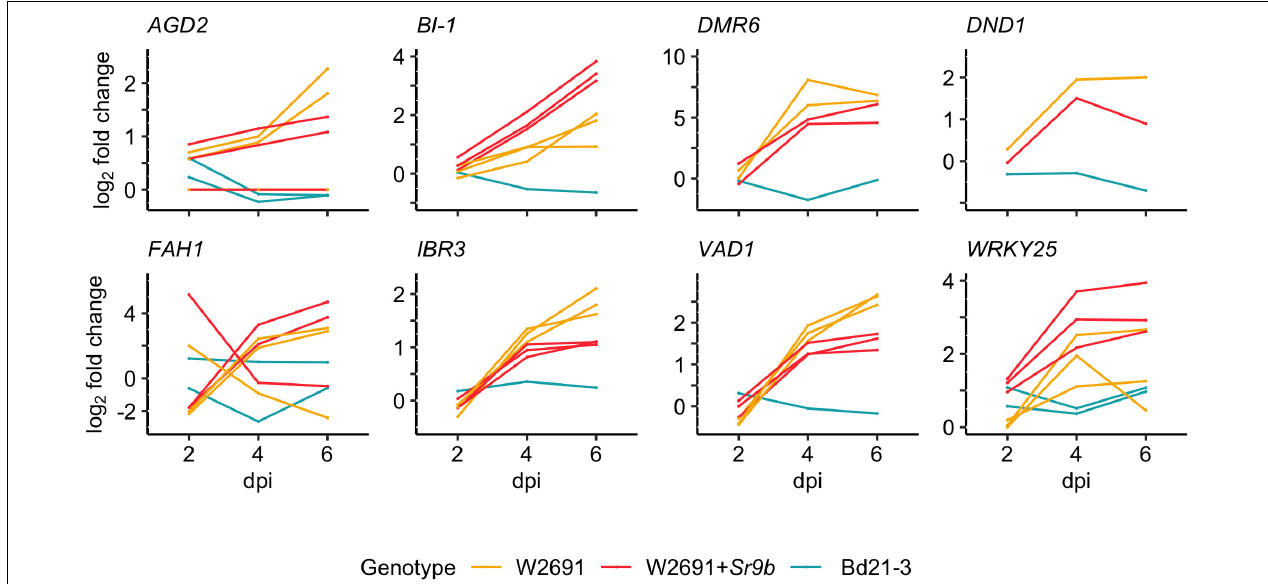
FIGURE 4 | RNAseq expression profile patterns of selected orthogroups containing candidate S genes in T. aestivum (W2691 and W2691+ Sr9b ) and B. distachyon (Bd21-3) genotypes throughout infection with P. graminis f. sp. tritici . Log 2 fold change values for all gene orthologs are presented for each infected genotype compared to the mock treatment per sampling time point. Gene IDs, average FPKM values, orthogroup, and co-expression cluster identifiers are presented in Supplementary Table 7 .